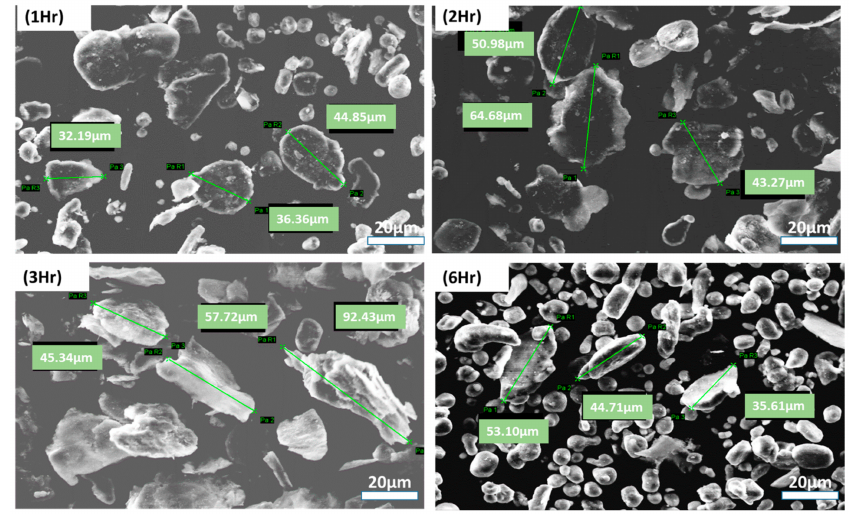
Figure 6. SEM images of the PVA coated Al powders ball milled at 300 rpm and different timings (1, 2, 3 and 6